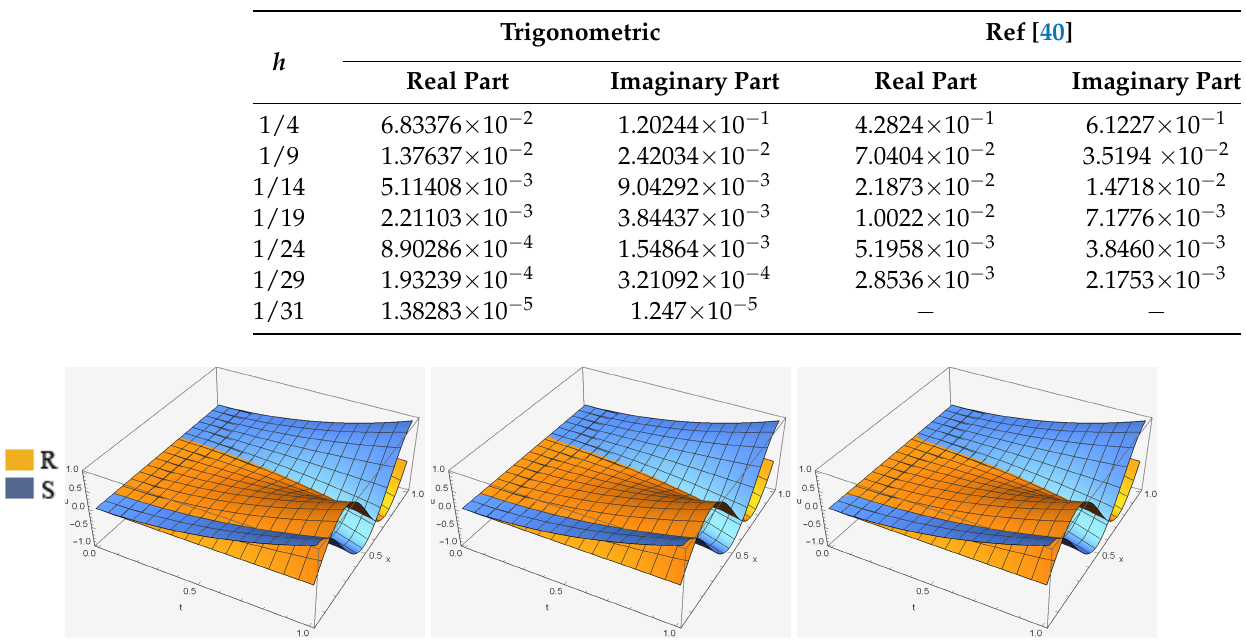
Table 8. Comparison of the error norms of real and imaginary parts in Equation (1) with Ref [40] for τ = 1/512, α = 0.1, a = 0, b = 1.